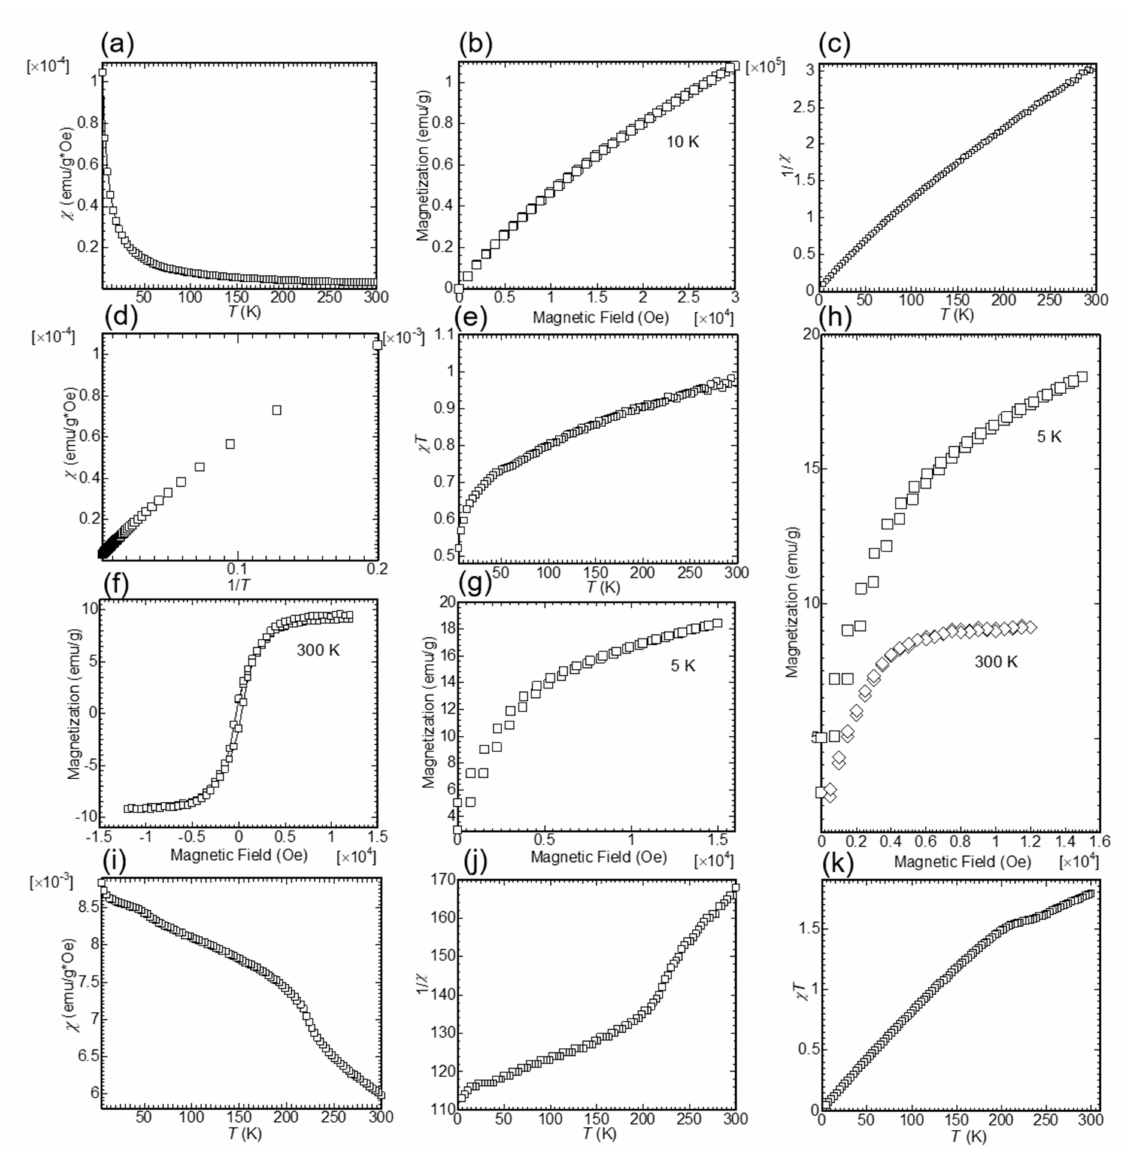
Figure 9. Superconducting quantum interference device (SQUID) measurement results of the B. braunii residue before and after carbonization. ( a – e ) Samples before carbonization: ( a ) Magnetic susceptibility ( χ ) ranged from 300 to 5 K; ( b ) M - H curve in 10 K; ( c ) 1/ χ vs. temperature ( T ) curve; ( d ) magnetic susceptibility vs. inverse temperature; ( e ) χ T vs. T curve. ( f – k ) Carbonized sample at 900 ◦ C: ( f ) M ( H ) loop at 300 K; ( g ) M - H curve at 5 K; ( h ) comparison between M - H curve of 300 and 5 K; ( i ) χ vs. T with an external field of 500 Oe; ( j ) 1/ χ vs. T curve; ( k ) χ T vs. T